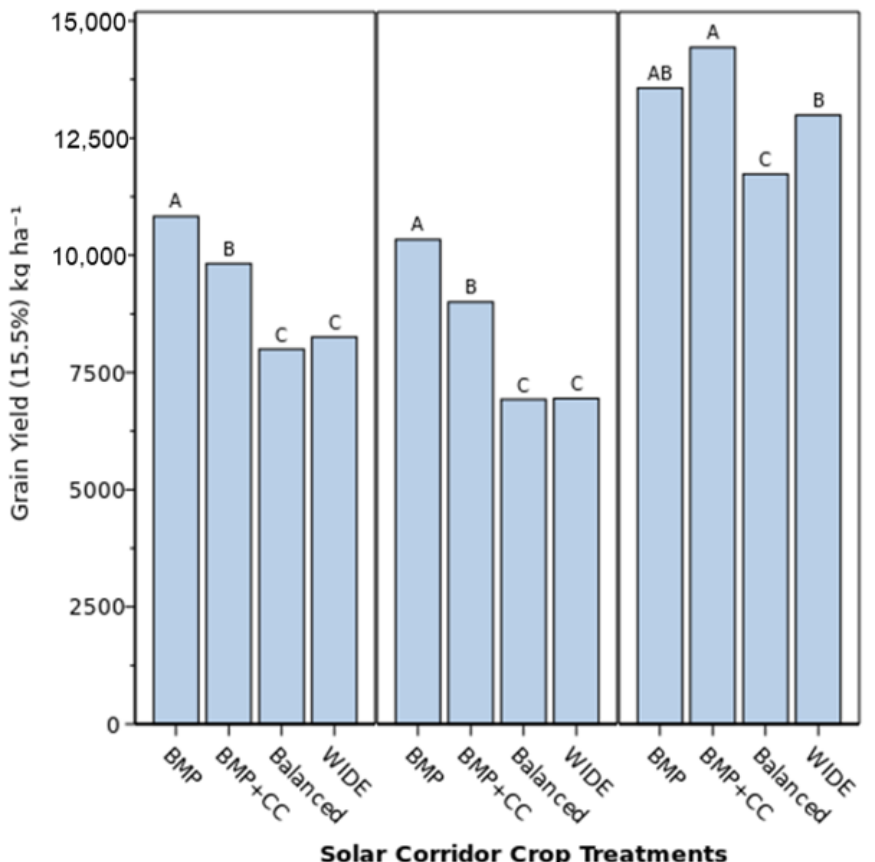
Figure 1. Row treatment and location effect on the grain yield at Goodhue, MN ( left ), USA Cherry Grove Township, MN ( center ), and Faribault, MN, USA (right) . BMP, 76-cm without cover crop; BMP + CC, 76-cm row with cover crop; Balanced, 76-cm with cover crops and two skip rows every fourth row; WIDE, 152-cm rows with cover crop. All mean separation values were based on Fisher’s protected LSD at α = 0.05.